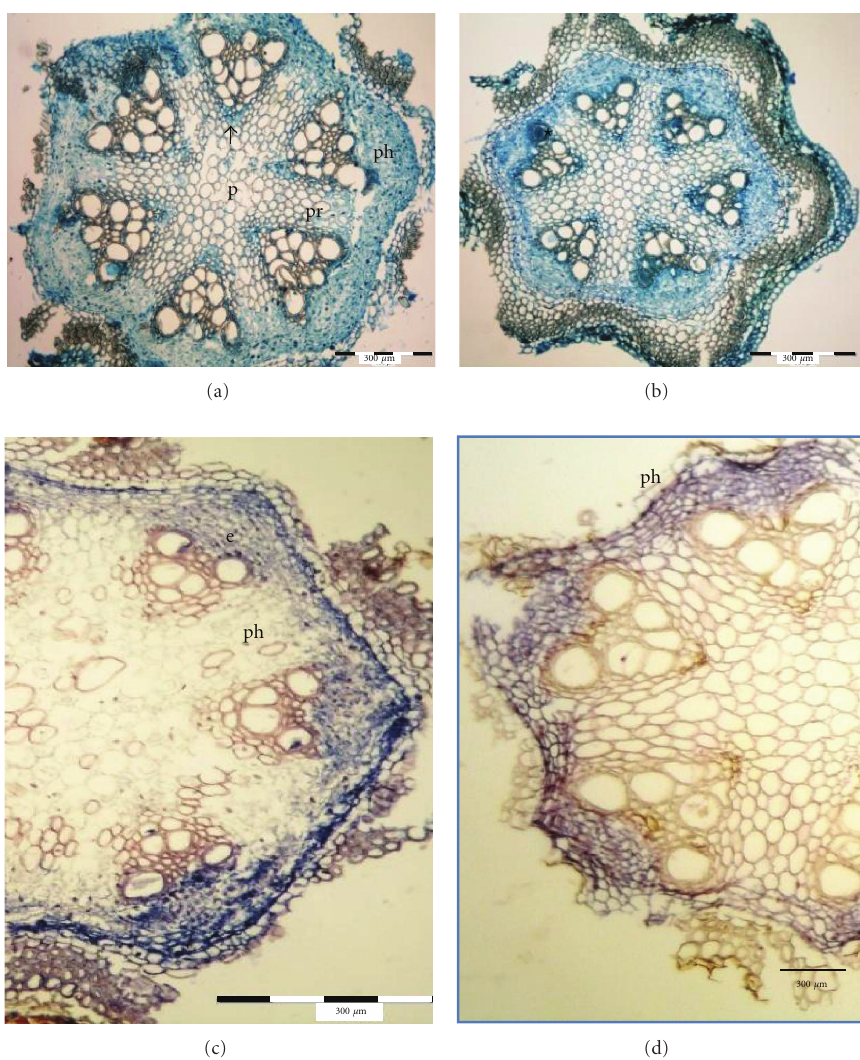
Figure 5: Histochemical identification of protein components and extensins in xylem occlusions in stems of Clematis “Solidarno´s´c” by using Bradford reagent and Jim11 antibody. (a) and (b) Identification of protein components in xylem of control stems (a), stems kept in distilled water (b), (c) and (d) identification of extensins in xylem of stems kept in distilled water (c) and 8HQC + 2% sucrose (d). p: pith, pr: pith rays, ph: phloem, arrow: xylem vessel, ∗ : blocked xylem lumen, e: